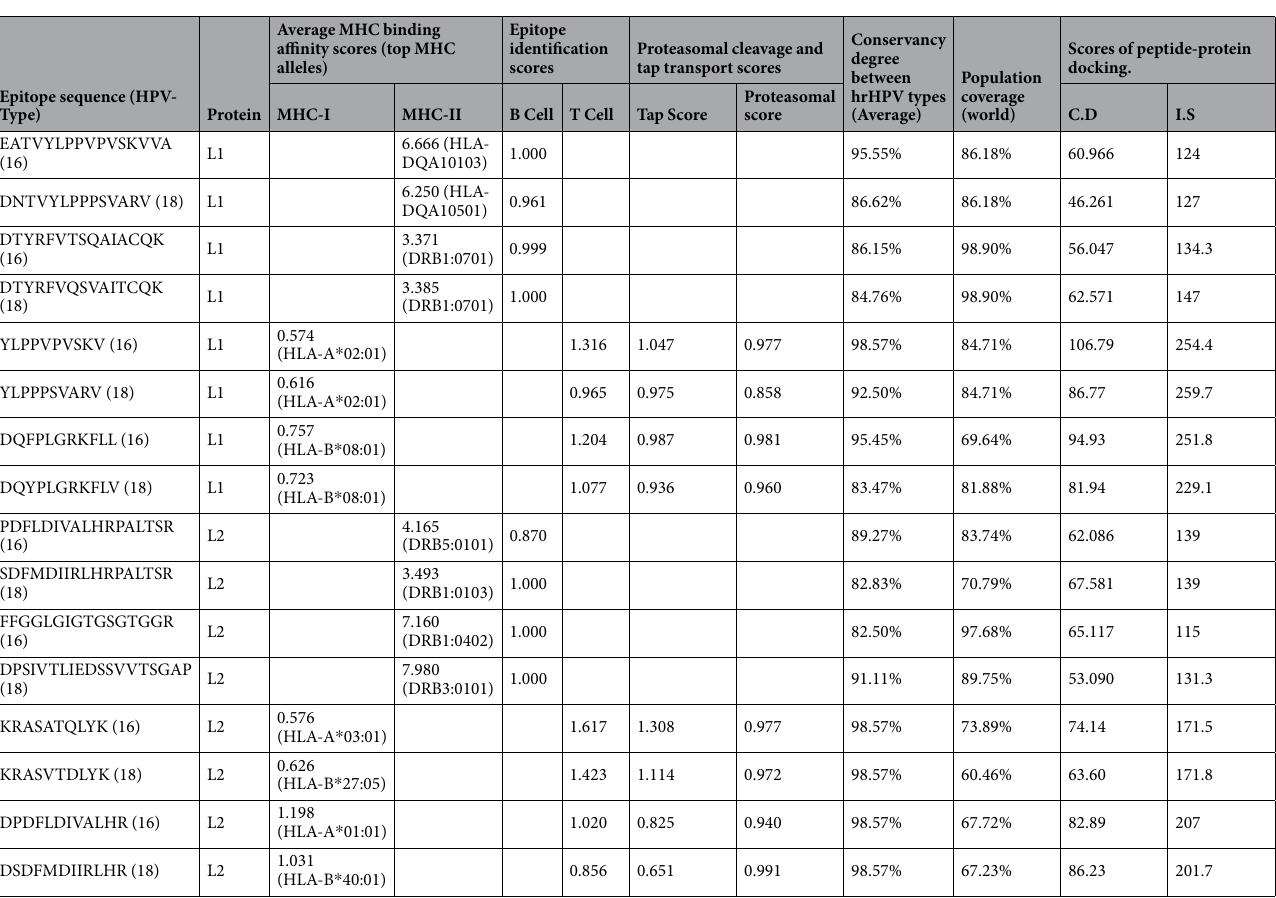
Table 14. In silico analysis of top ranked epitopes.